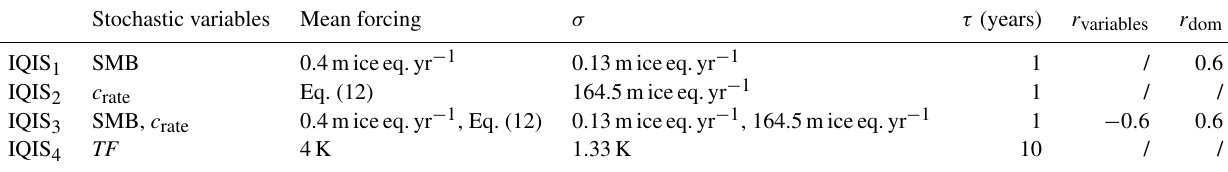
Table 1. Configuration of the IQIS transient ensemble experiments. τ = 1 year corresponds to annual noise uncorrelated in time. σ c equal to 1 / 3 of the mean of Eq. (12) evaluated at the front location. Note that all σ values are taken as 1 / 3 of the corresponding mean forcing. The noise correlation between variables ( (cid:15) SMB and (cid:15) c in the exterior sub-domain in IQIS 3 ) is represented by r variables , and r dom is the rate correlation in (cid:15) SMB between the interior (rad ≤ 300km) and exterior (rad > 300km) parts of the